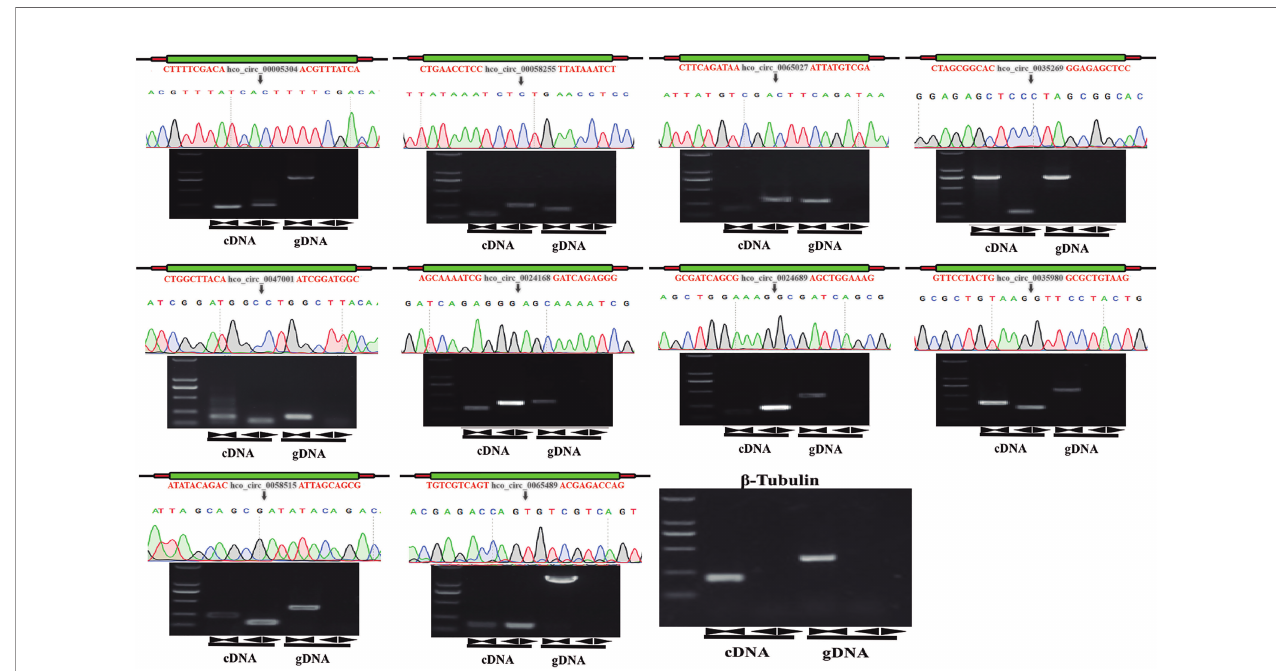
FIGURE 5 | Experimental validation of back-spliced junction sites of candidate circRNAs. Linear RNAs were successfully ampli fi ed by convergent primers from both cDNA and gDNA. CircRNAs were successfully ampli fi ed by divergent primers from cDNA but failed to be ampli fi ed from gDNA. PCR products were detected by 1% agarose electrophoresis. The head-to-tail back-splicing site was further con fi rmed by Sanger sequencing. Black inverted triangles represented the back-spliced junction loci, and b -tubulin gene was used for the control group. Marker: 2000 bp ladder DNA